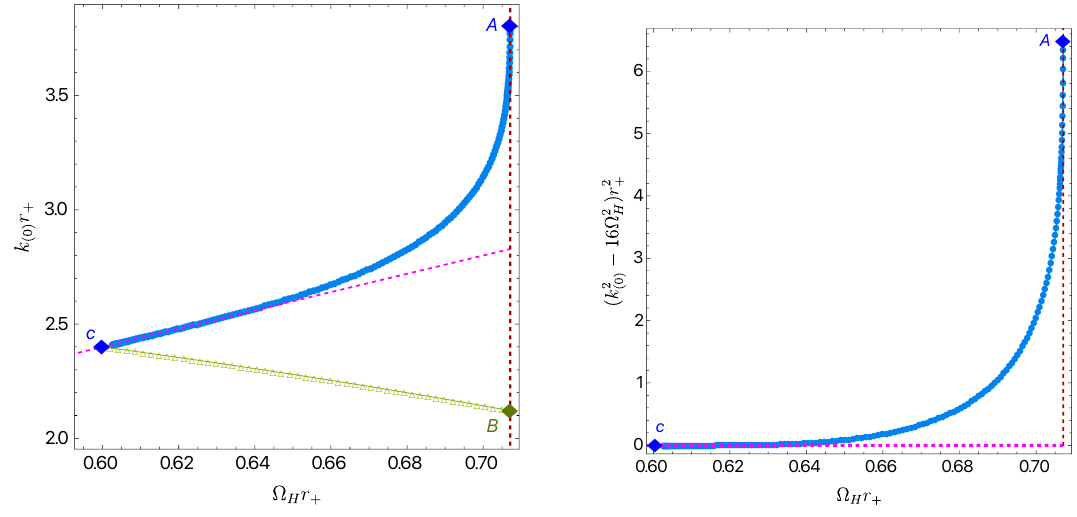
Figure 3 . The blue disk curves with endpoints A and c corresponds to the m = 2 onset mode (with ω = 2 m e Ω H ) of the superradiant instability of the Myers-Perry black string. This curve e √ exists in the window e Ω H | c ≤ e Ω H ≤ e Ω H | A where e Ω H | c = 3 / 5 and e Ω H | A ≡ e Ω ext = 1 / 2 is the H angular velocity at extremality (the vertical dashed line identifies this extremality). Left: Myers- Perry black strings are superradiant unstable in the triangular region ABc bounded by the shown curves. Besides the onset curve ( Ac ), we also show the green curve e k ? ( e Ω H ) , which describes modes with Re ω = e k (and Im ω = 0 ). This green curve e k ? ( e Ω H ) begins at point c where it e e intersects the magenta dashed line e k = 2 m e Ω H (with m = 2 ), and ends at point B where e Ω H = √ √ 2 . For reference, point A has ( e Ω H , e k , e L ) A ' (1 / 2 , 3 . 805857 , 1 . 650925) , point B e Ω ext H = 1 / (0) (0) √ √ √ has ( e Ω H , e k , e L ) B = (1 / 2 , 3 / 2 , 2 2 π/ 3) , and point c has ( e Ω H , e k , e L ) c = (3 / 5 , 12 / 5 , 5 π/ 6) , (0) (0) (0) (0) where e L = 2 π/ e k . Right: this plot demonstrates that the onset curve Ac satisfies e k 2 − 4 m 2 e Ω 2 ≥ (0) (0) H (0) 0 , which implies that these onset modes decay exponentially in the radial